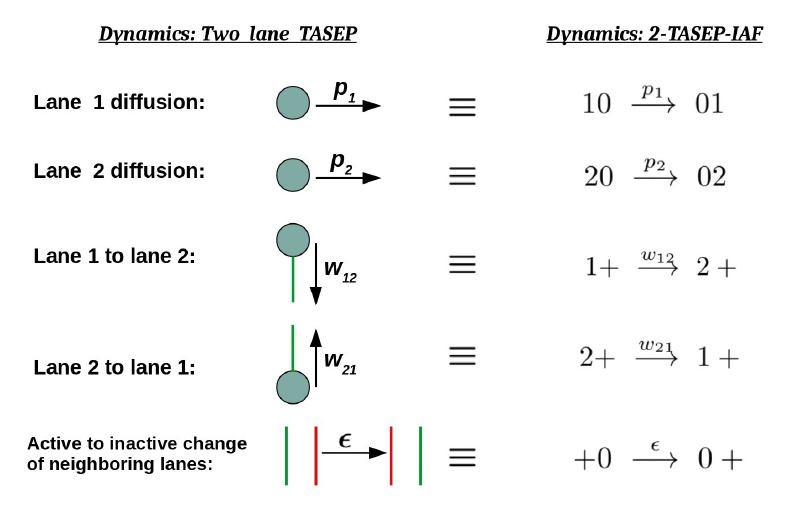
Figure 12: The figure shows the connection between each microscopic dynamics of the two lane TASEP with the equivalent microscopic dynamics in the